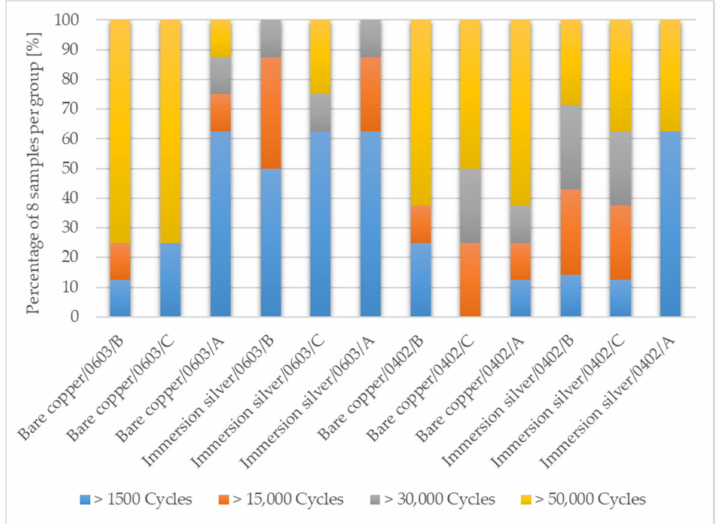
Figure 10. Achieved dynamic bending cycles to failure in categories for the different process variation for soldered SMDs on foil.